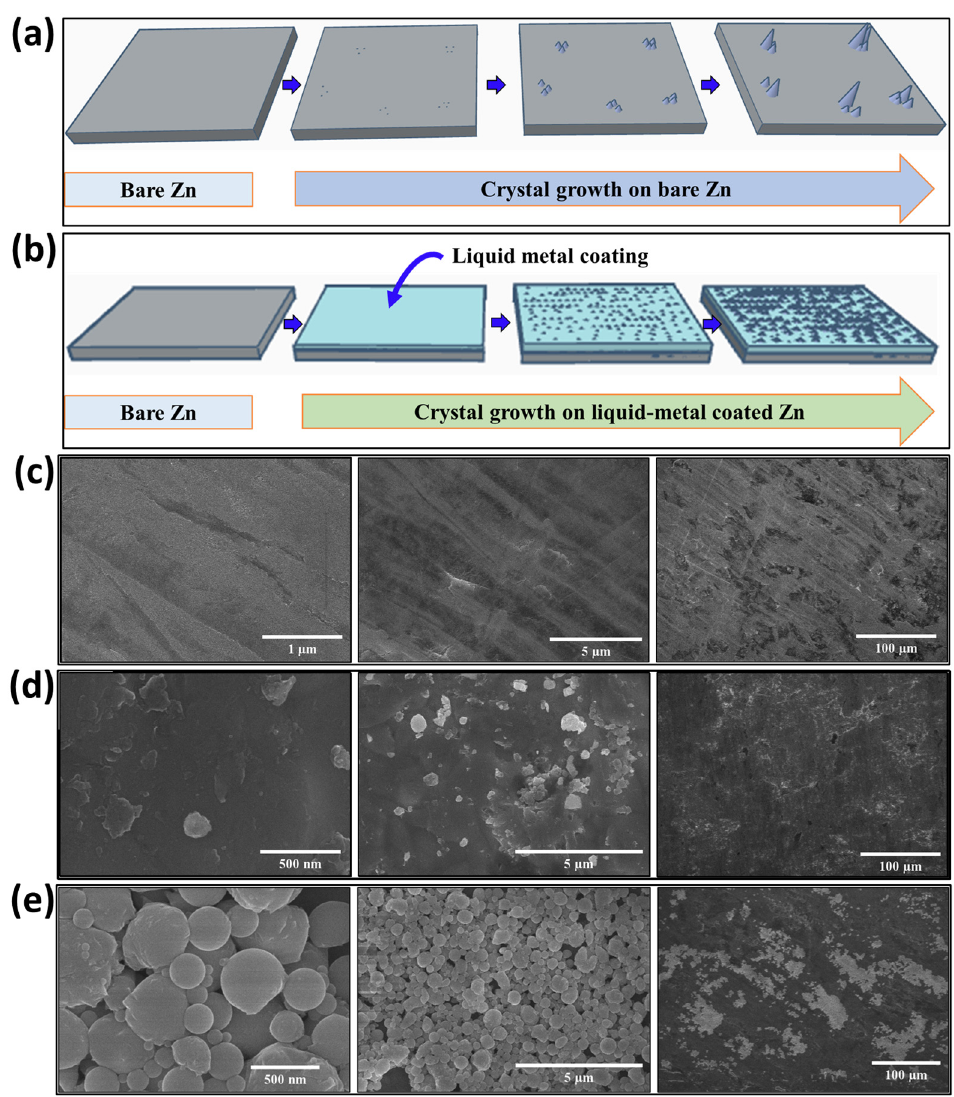
Figure 1. Schematic of Zn 2+ ion deposition/striping in ( a ) bare Zn anode and ( b ) in room-temperature bulk liquid-metal-coated Zn@BLM electrodes; SEM images of ( c ) bare Zn anode; ( d ) Zn@BLM and ( e ) Zn@LMNP electrodes.